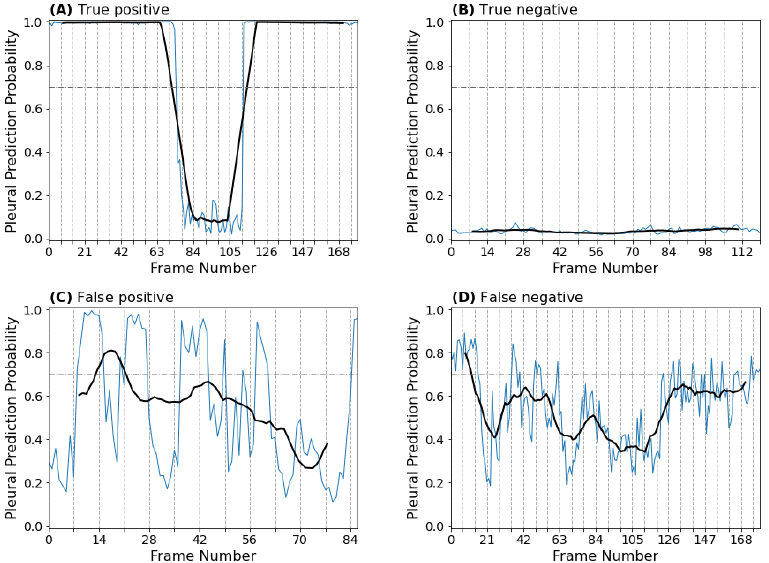
Figure 7. Pleural prediction probability time series for selected true positive ( A ), true negative ( B ), false positive ( C ), and false negative ( D ) clips. The true positive ( A ) clip displays the curtain sign artifact which indicates the lack of pleural pathology (consolidated lung or pleural effusion). The true negative ( B ) clip displays normal lung parenchyma (A line pattern) bordered by rib shadows. The false positive ( C ) clip contains heart tissue, which the model likely mistook for an abdominal organ usually seen in pleural views. The diaphragm is largely missing from the false negative clip ( D ), with only a sliver appearing on a few occasions that correspond to bursts in pleural prediction probability; however, the average probability does not remain above the classification threshold long enough to meet the contiguity threshold. Supplementary Videos